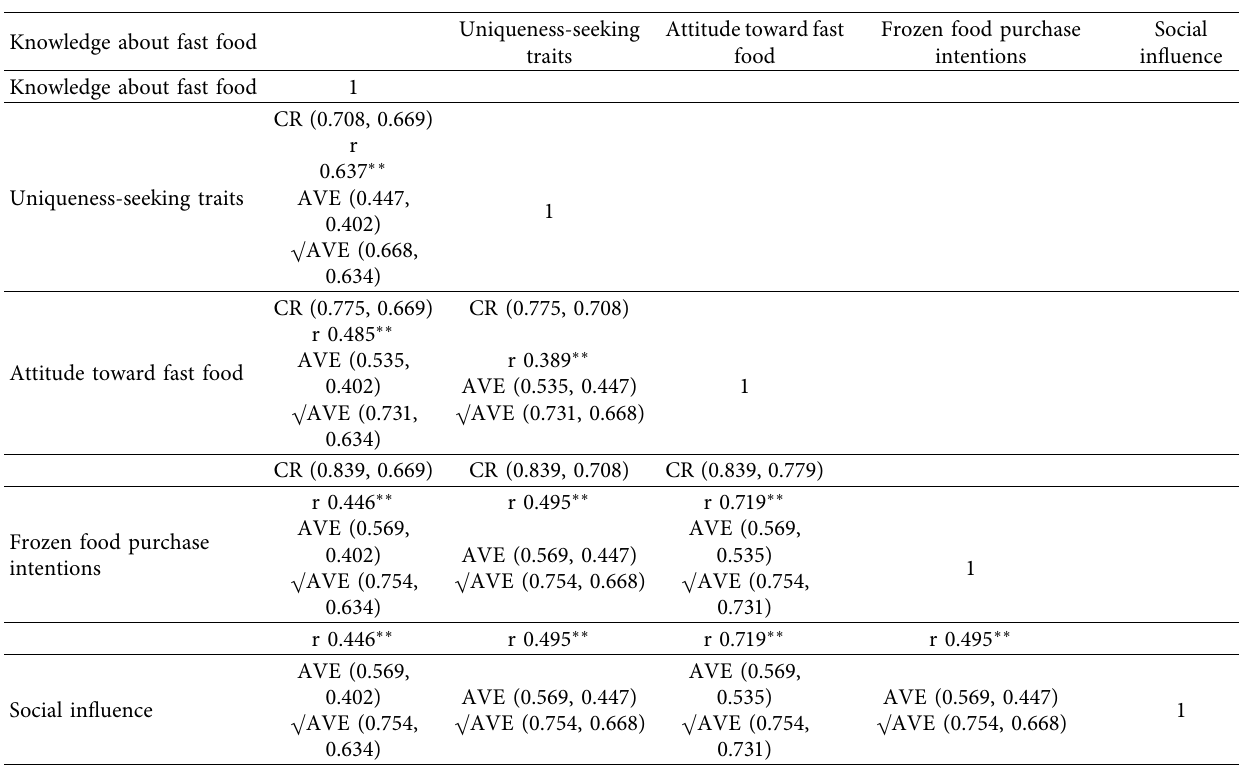
Table 9: Validities of the construct.